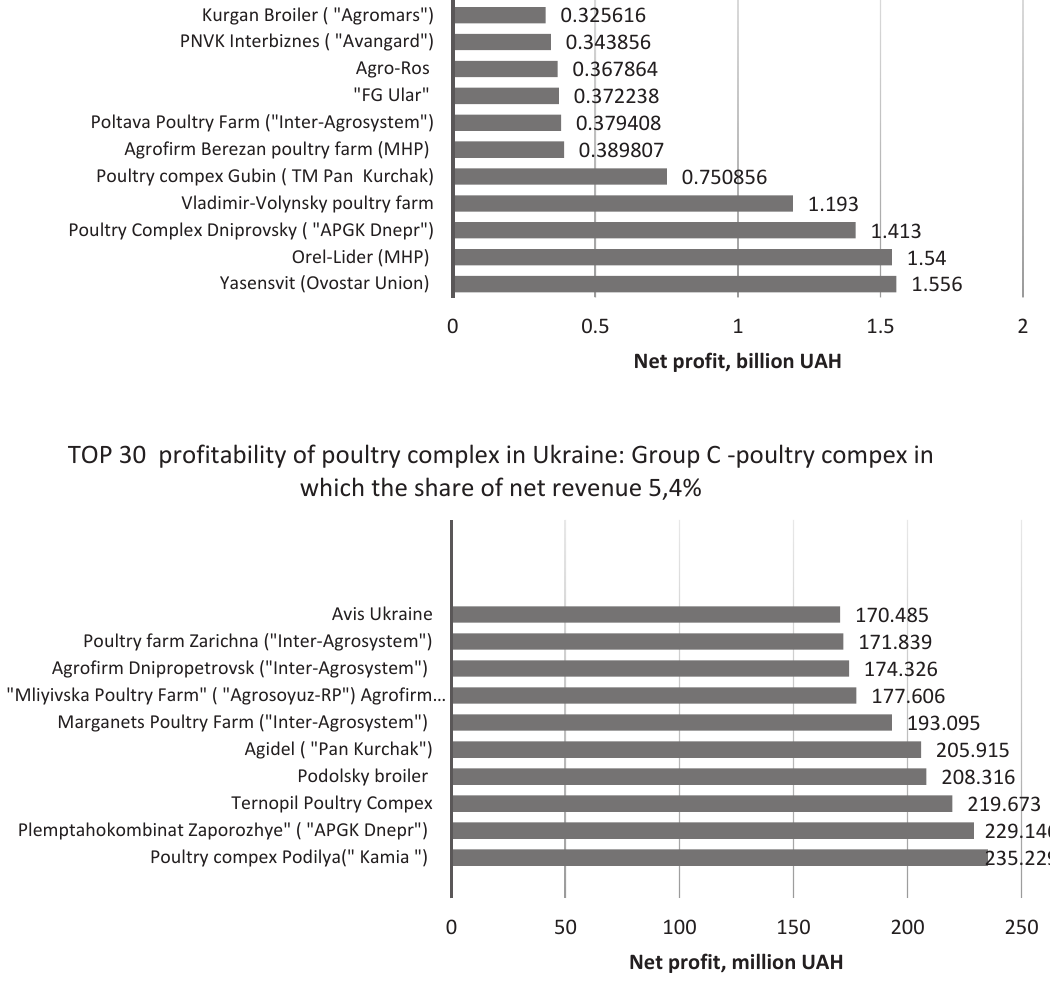
Figure 2. Poultry producers ABC analysis in